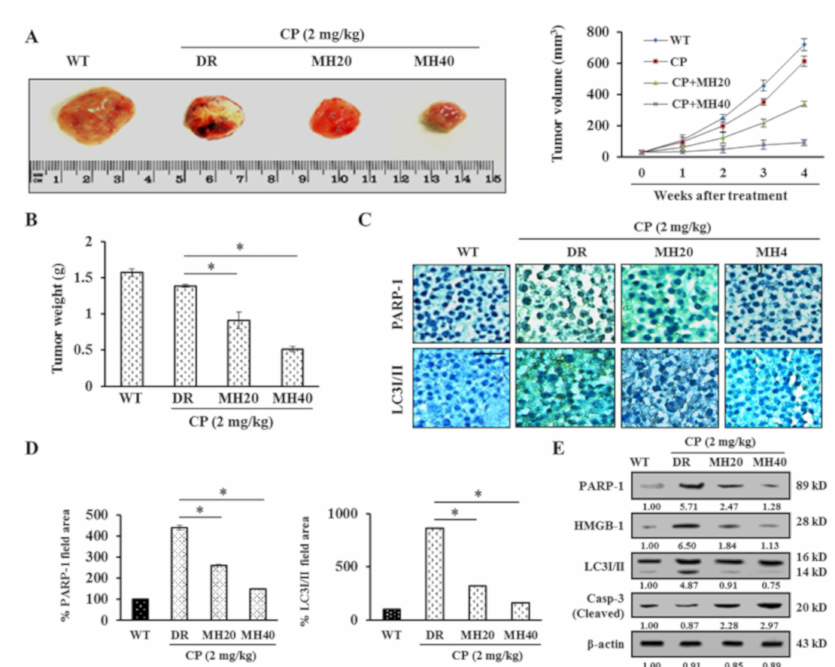
Figure 7. MH potentiates the antitumor e ff ect of CP on HepG2 DR cell xenograft. ( A ) Representative images showing regression in tumor volumes after treatment with CP-MH compared with those in the vehicle-treated groups of HepG2 DR cell xenografts in nude mice. ( B ) Surgically resected tumors from vehicle and CP-MH-treated xenograft mice; changes in tumor weights were observed after initiation of treatment. ( C ) Expression levels of PARP1 and LC3I / II were evaluated using an immunohistochemistry assay with specific antibodies (magnification: 200 × ; scale bar: 0.1 mm). ( D ) Percentage of the area of representative proteins (PARP1 and LC3I / II) was quantified using the ImageJ software. ( E ) Expression level analysis of PARP1, HMGB1, LC3I / II, and cleaved caspase-3 by Western blotting after CP-MH treatments in HepG2 DR cell xenograft tissues. Relative intensities were measured by ImageJ software. Data represent the mean ± SD of three independent experiments ( n = 5). * p < 0.05, ** p <